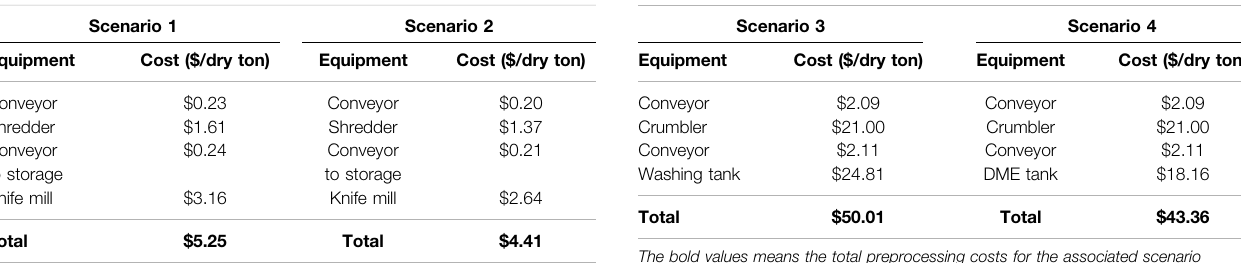
TABLE 5 | Breakdown of costs for detergent washing (scenario 3) and DME- based (scenario 4) pre-processing unit